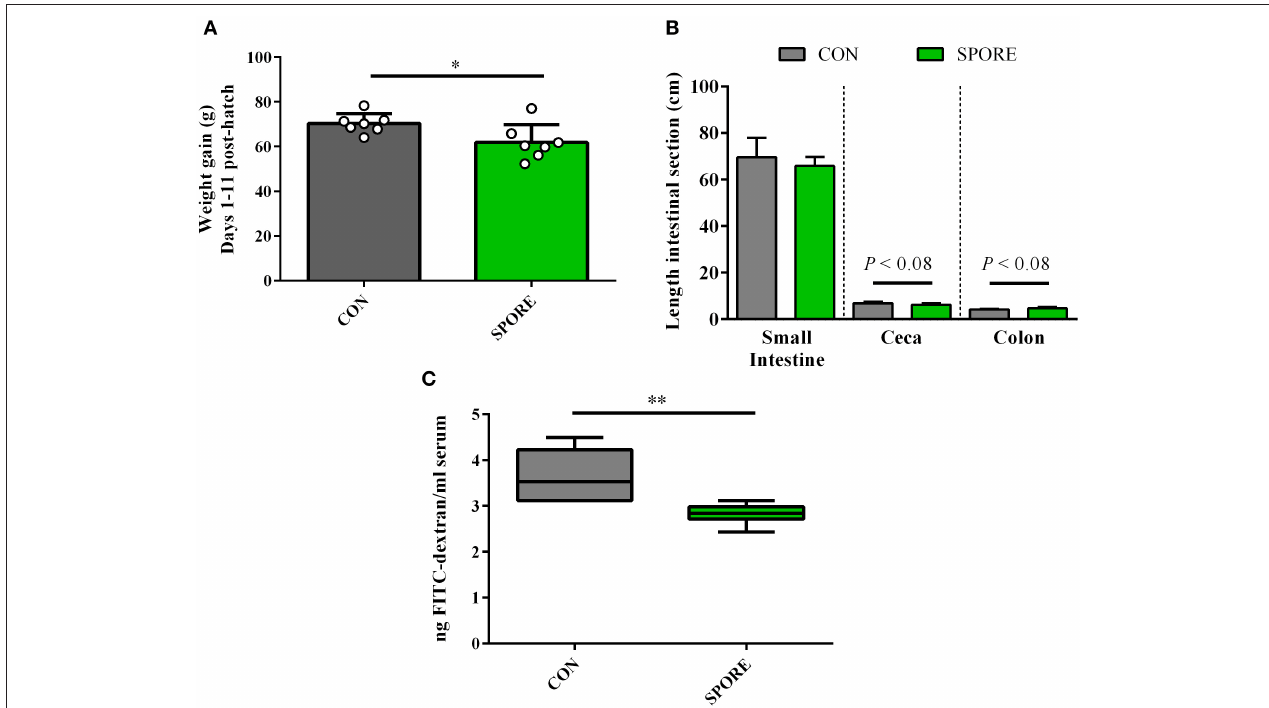
FIGURE 5 | Measures of weight gain and gut morphology. (A) Chick weight was measured at 1 and 11 days post-hatch to assess average weight gain per animal. (B) Intestinal segment lengths were measured via ruler at 14 days post-inoculation (dpi). (C) Gut permeability was measured at 3 dpi via orally-delivered FITC-dextran leakage in serum. * P < 0.05, ** P <